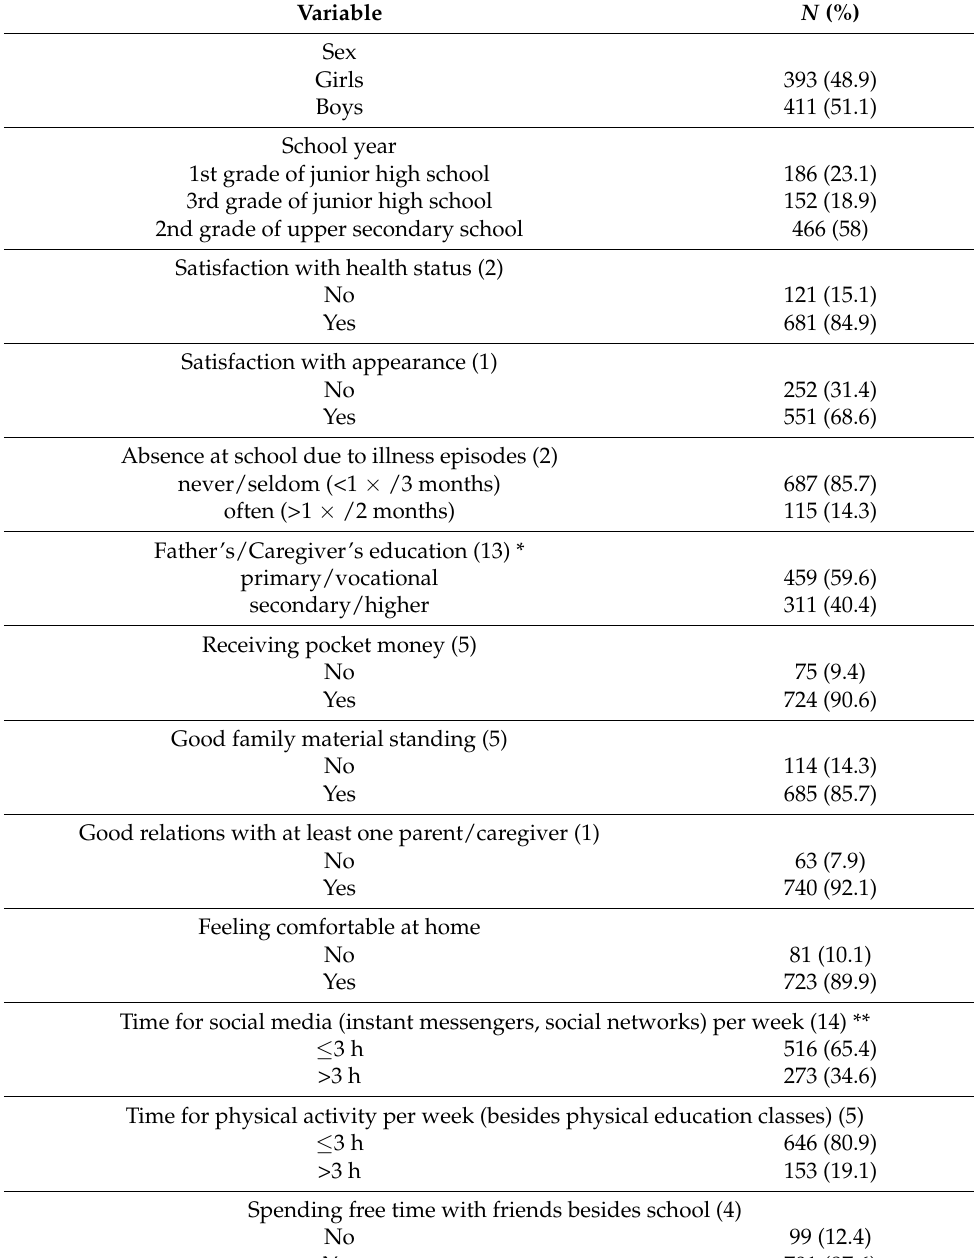
Table 1. Characteristics of the sample in adolescents aged 12–18 years ( n =